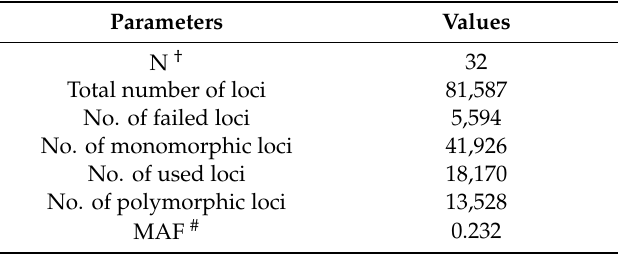
Table 2. Summary statistics of genetic variation obtained by the wheat 90k single nucleotide polymorphisms (SNP) array in 27 landraces and 2 historical varieties (Cappelli and Trinakria), belonging totheSicilianwheatgermplasm. ThemodernvarietiesClaudioandSimetowerealsoaddedasreferences, while the hexaploid Cuccitta landrace ( T. aestivum L.) was included as an outgroup.